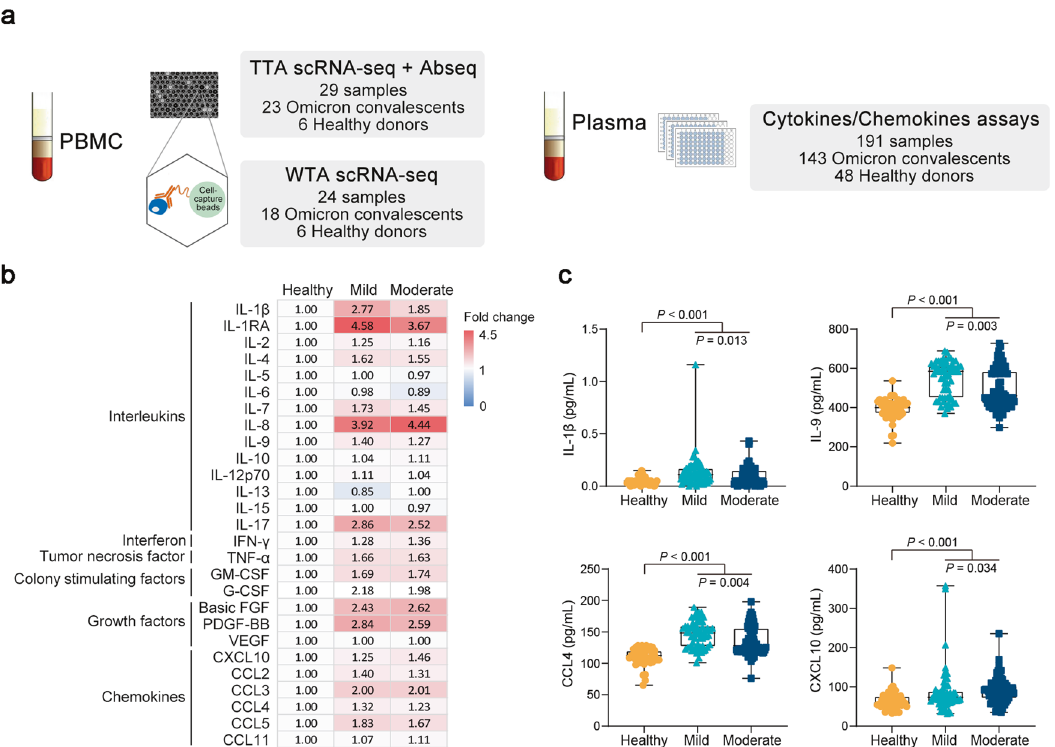
Fig. 1 Schematics of the overall study design and plasma levels of cytokines and chemokines in SARS-CoV-2 Omicron convalescents. a Schematics depicting the overall experimental design of this study. Peripheral blood mononuclear cells (PBMCs) and plasma were collected from SARS-CoV-2 Omicron convalescents and matched healthy controls and then processed to single-cell RNA sequencing (scRNA-seq), surface proteome pro fi ling (Abseq), and cytokine and chemokine assays. b , c Plasma levels of cytokines and chemokines from SARS-CoV-2 Omicron convalescents ( n = 143) and healthy controls ( n = 48). SARS-CoV-2 Omicron-infected individuals were divided into mild ( n = 62) and moderate ( n = 81) disease severity groups according to WHO living guidance for clinical management of COVID-19. Twenty-seven cytokines and chemokines were measured by the Bio ‐ Plex pro human cytokine assays and MAGPIX system (Luminex). Fold change of average plasma concentrations of cytokines and chemokines were shown in ( b ), and the differences in cytokines and chemokines between mild and moderate convalescents were shown in ( c ). Statistical signi fi cance was determined by two-tailed Mann – Whitney U